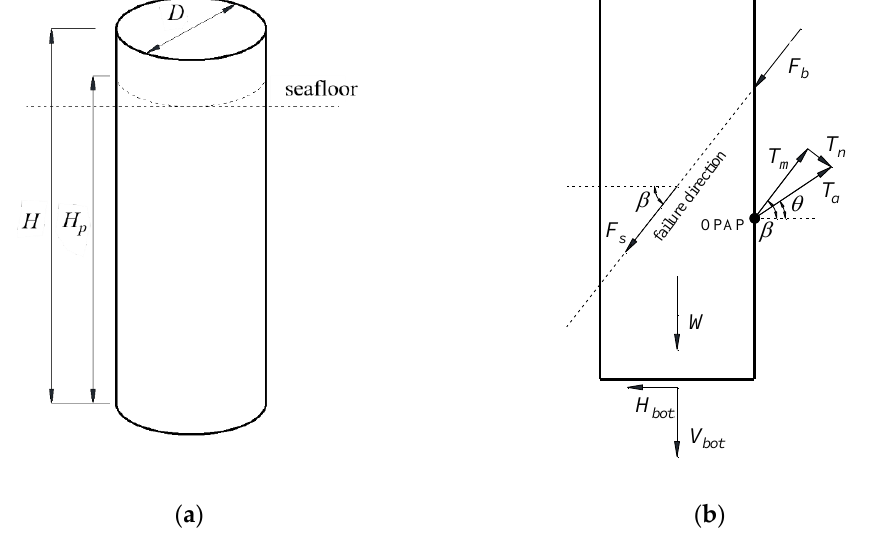
Figure 4. Definition of anchor behaviors and mechanical model for a GIA: ( a ) Diving; ( b ) Pulling out; ( c ) Keying.